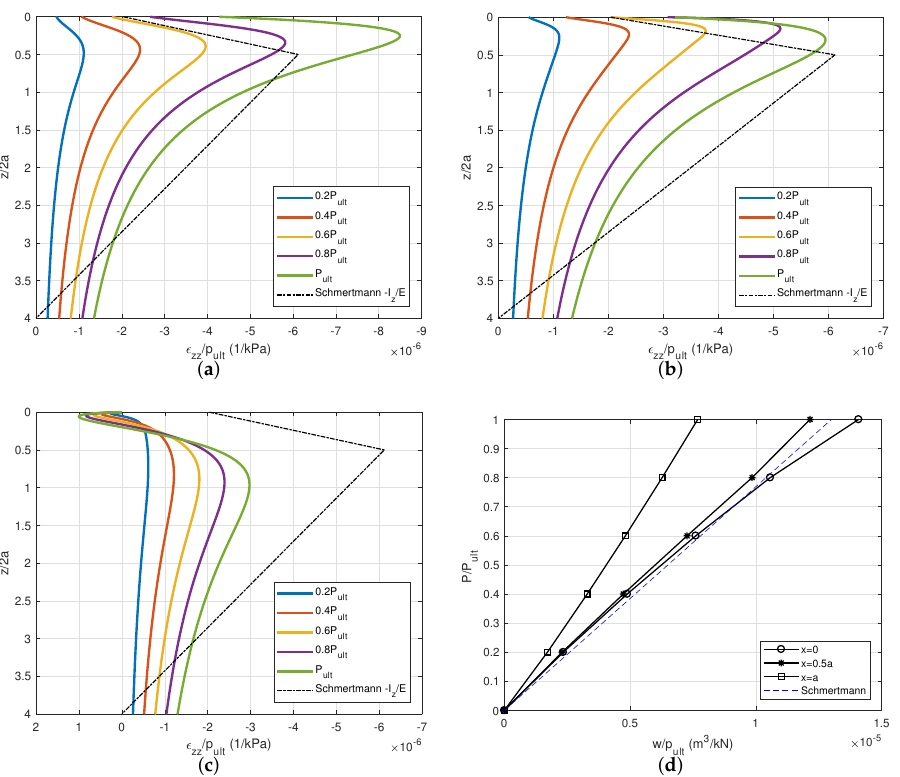
Figure 7. Vertical strain (cid:101) zz and approximate displacements beneath the evolving elastoplastic loading conditions of Figure 6. Elastic constants are taken as E = 98,000 kPa, ν = 0.4. ( a ) (cid:101) zz at x = 0; ( b ) (cid:101) zz at x = 0.5 a ; ( c ) (cid:101) zz at x = a ; ( d ) Approximate displacements estimated by Equation (20) with applied force, normalized by bearing capacity P ult